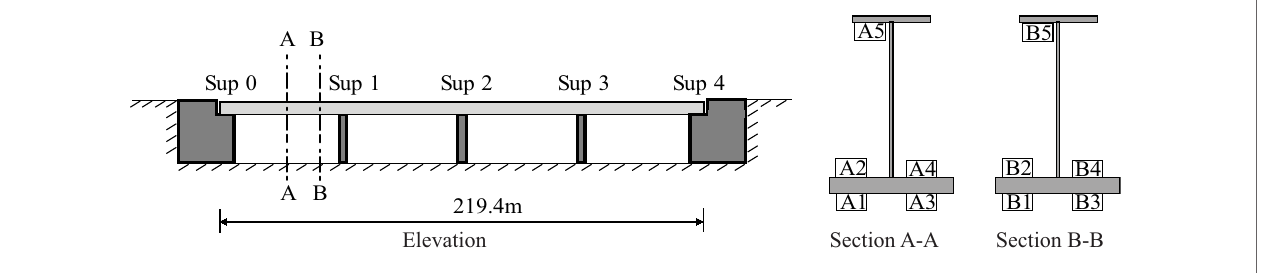
FIGURE 2 | Sensor locations on the Venoge bridge.